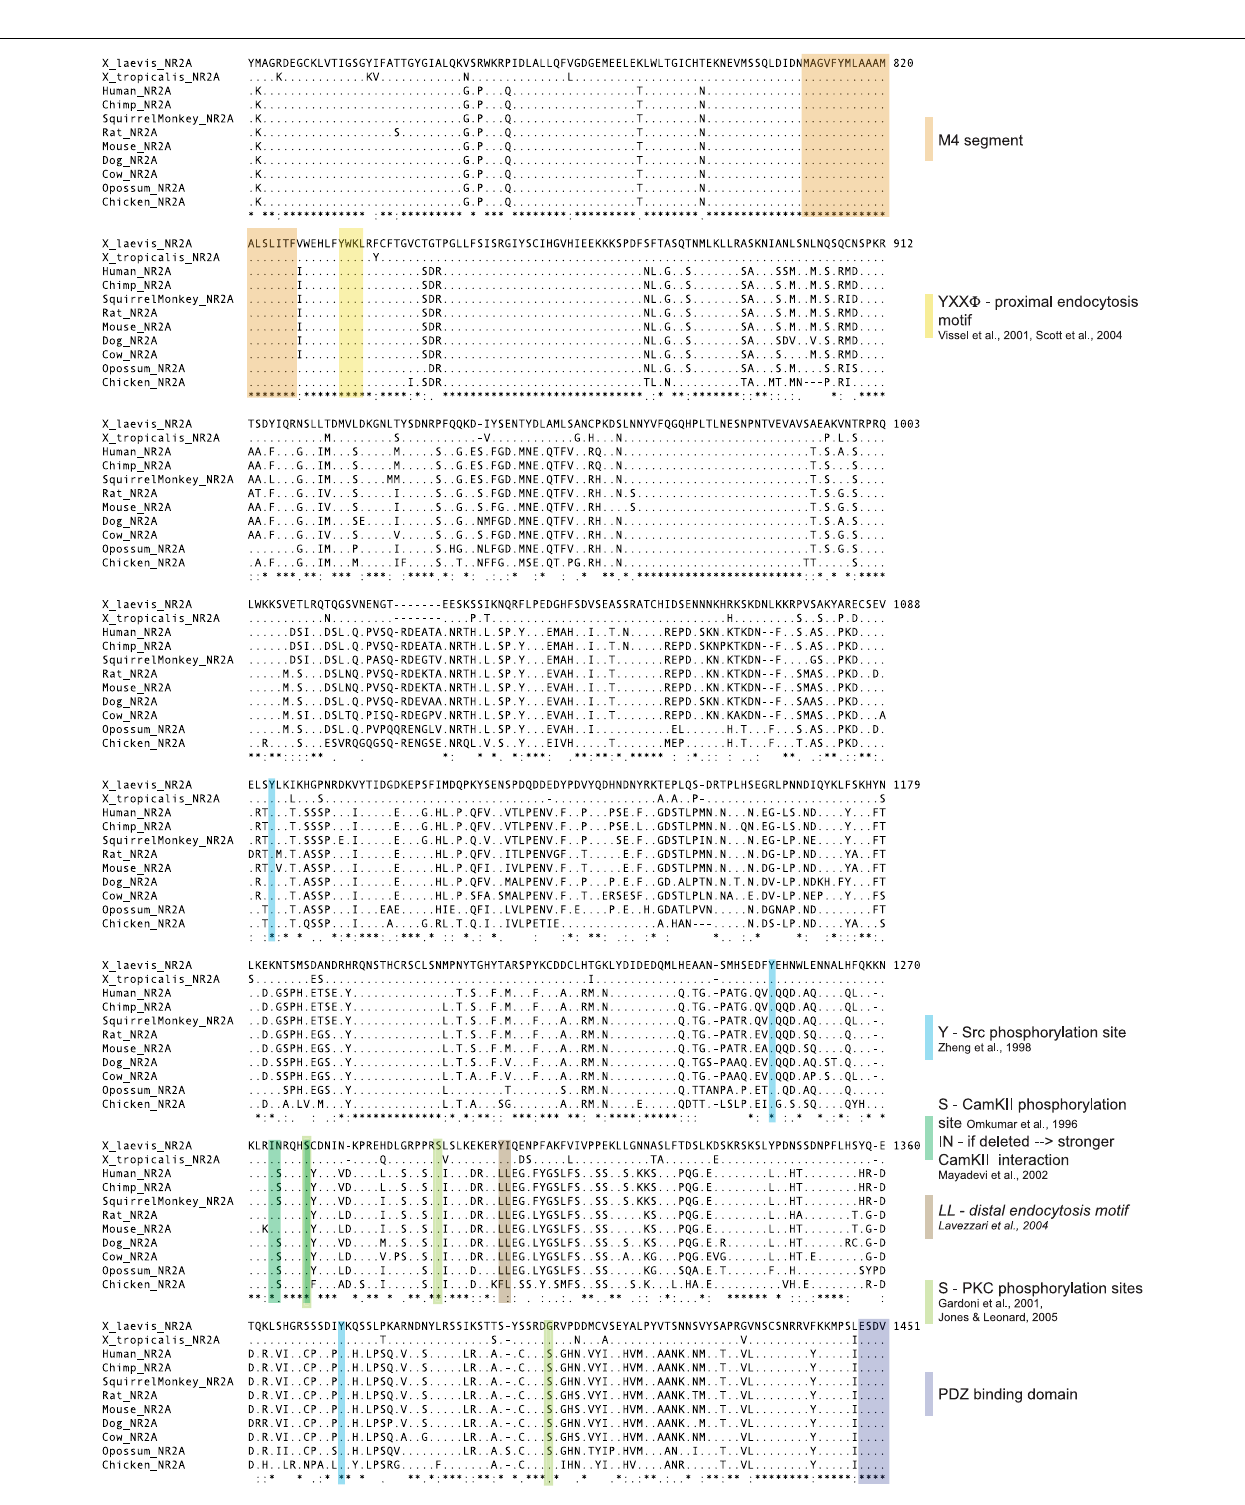
(:) and (.) indicate the degree of amino acid similarity. NR2A is highly conserved between species. The membrane-associated segments M1–M4, other structurally and functionally important domains and amino acids, as well as known protein–protein interaction domains and phosphorylation sites are highlighted. Descriptions in italics indicate sites that are not conserved between